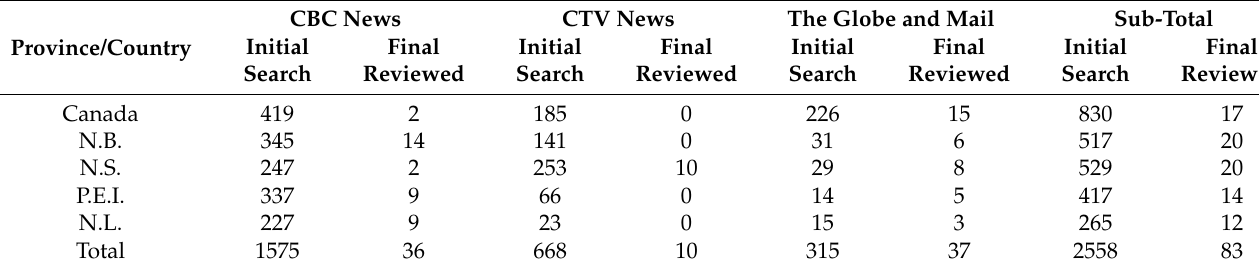
Table 2. The numbers of initial search and final reviewed news